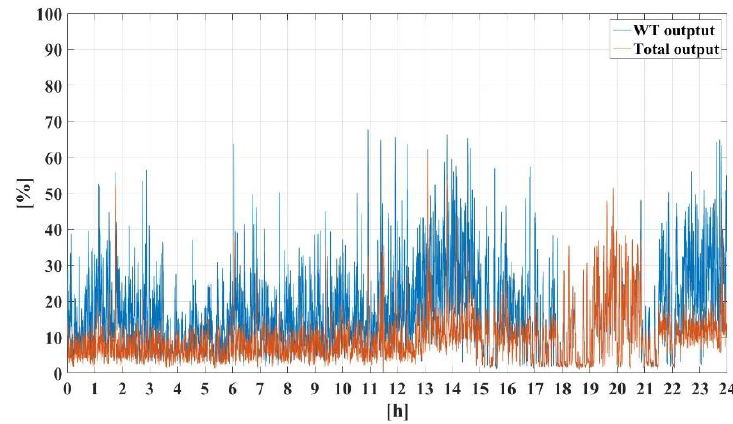
Figure 17. Field test result 3: fluctuation rate per minute.